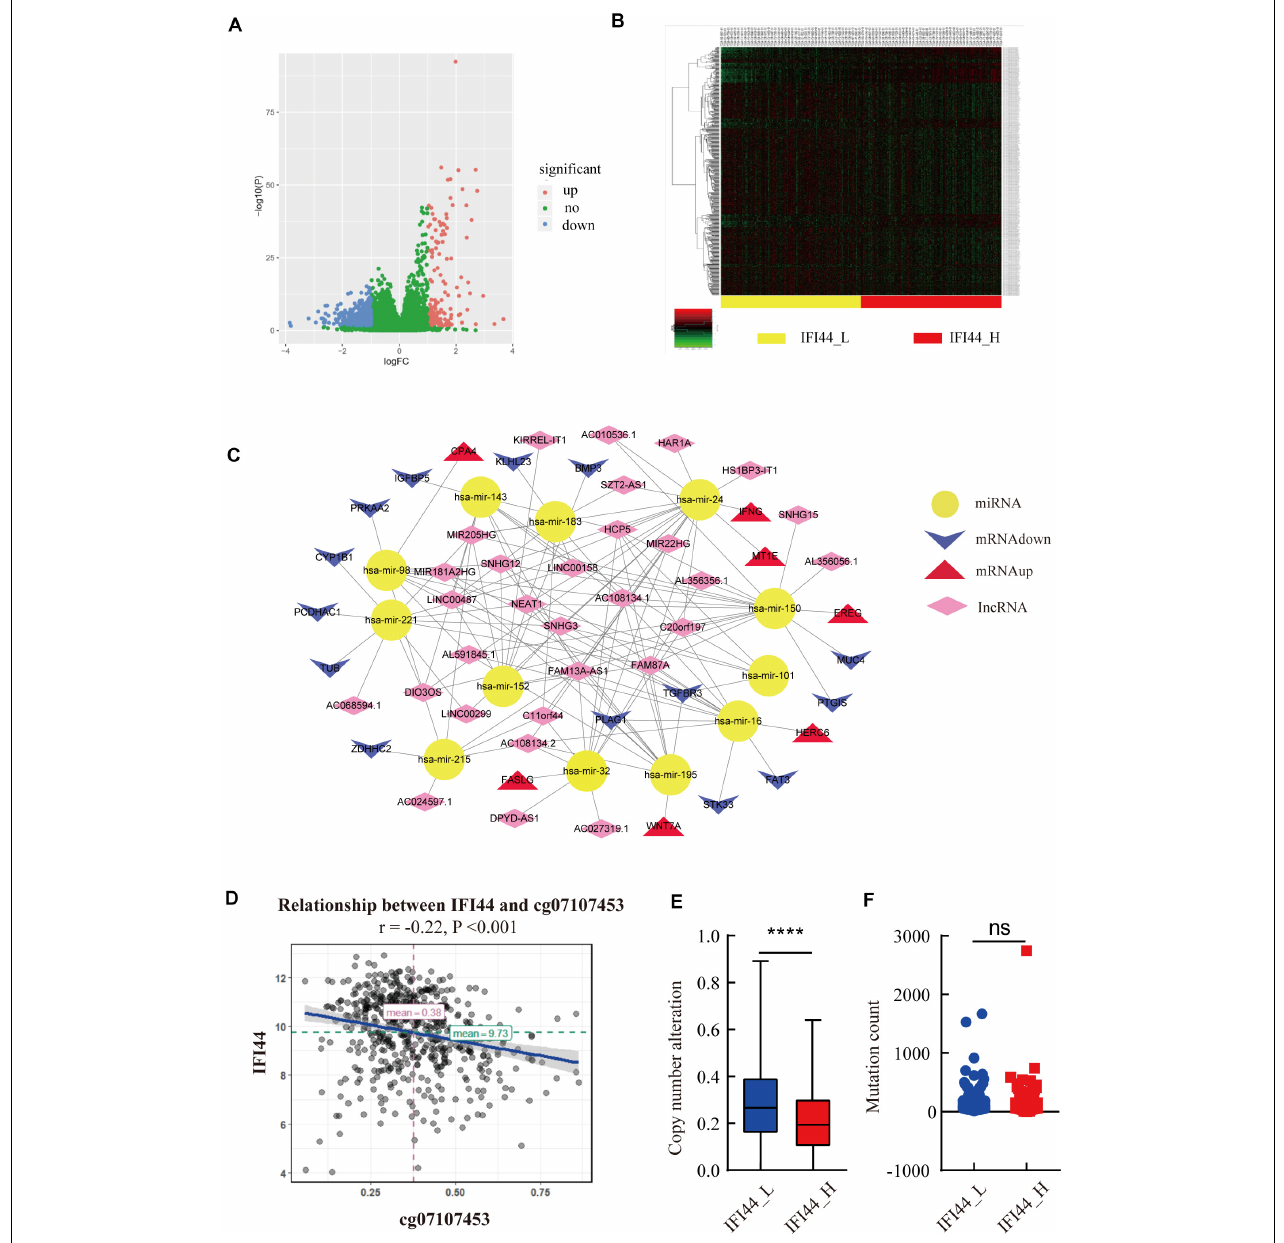
FIGURE 6 | The upstream analysis associated with IFI44 overexpression in head and neck squamous cell carcinoma (HNSC). (A–C) The competing endogenous RNA (ceRNA) network associated with IFI44 expression. (D) The relationship between IFI44 expression and methylation level. (E,F) The copy mutation alteration and mutation count of IFI44-high expression group vs. IFI44-low expression